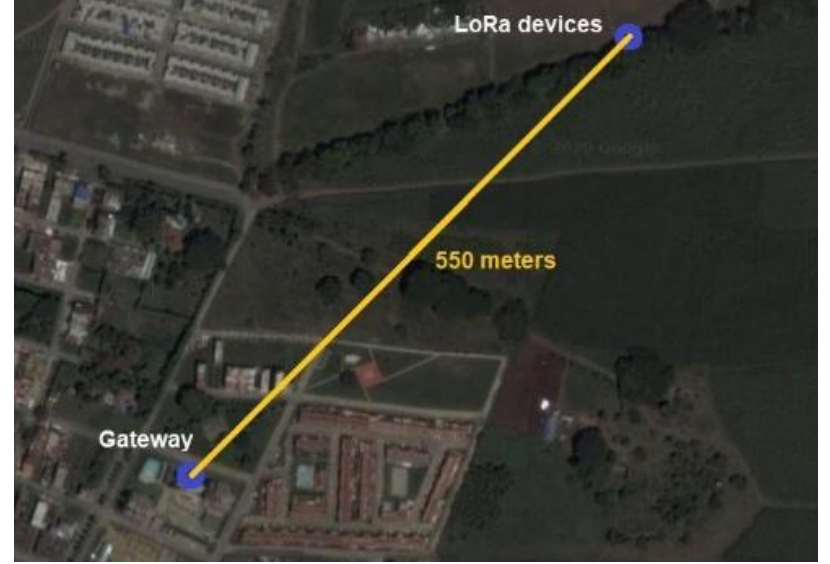
Figure 4. Location of the gateway and long ‐ range (LoRa) devices from Experiment 3.